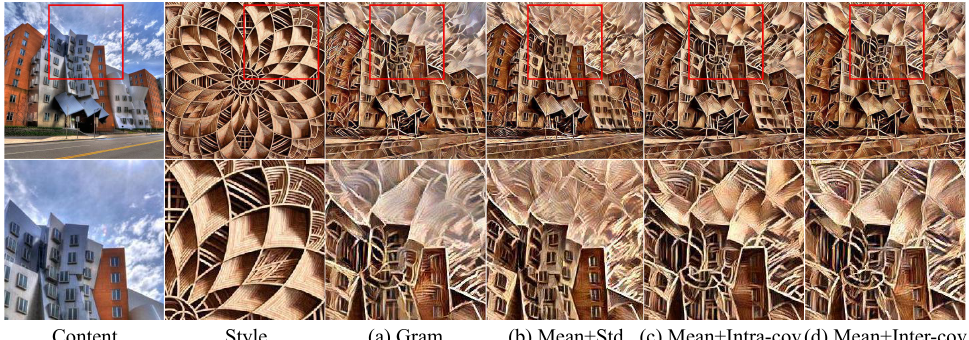
Figure 10. Comparison of style losses: each image is generated by using the specified style loss and the pixel-wise optimization method [1]. The images on the first row represent the original images and the image on the second row are the magnified images of the red box regions on the original images.